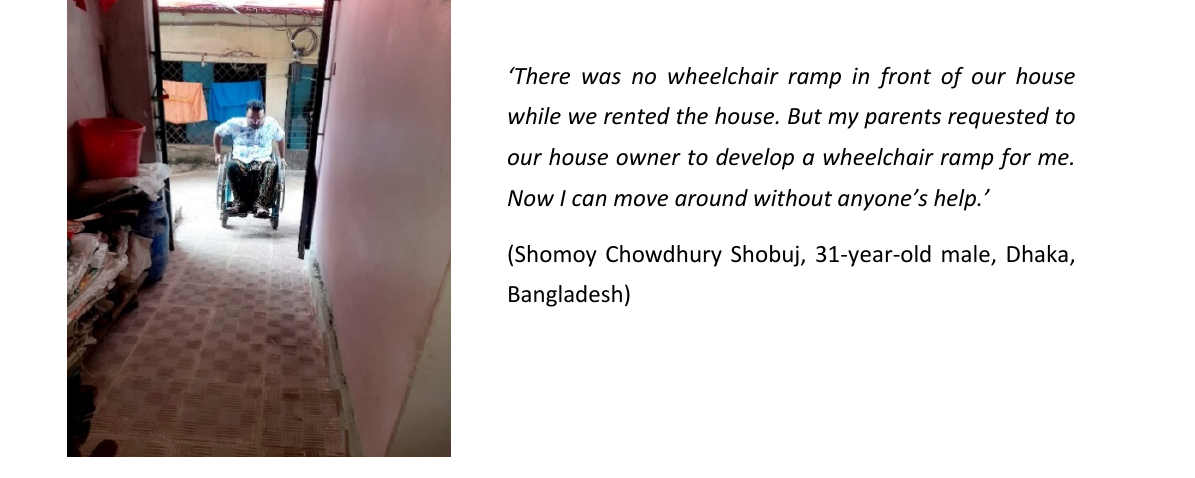
Figure 12. Alt-text: A man in a wheelchair being able to move freely in the entrance of his home.